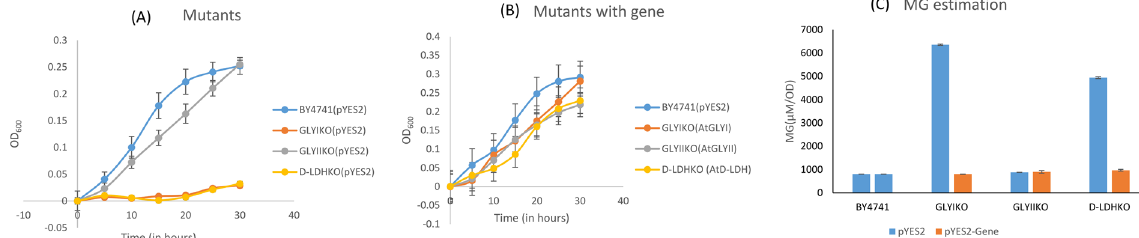
Figure 3. Stress tolerance assay in yeast mutants of MG detoxification enzymes in salinity stress: BY4741 wild type yeast cells, GLYIKO, GLYIIKO and D-LDHKO mutant yeast cells containing empty vector pYES2 were grown in presence of salinity stress ( A ). These mutant cells were transformed with their respective mutant genes cloned in pYES2 vector and the complemented yeast cells were grown in presence of salinity stress and their growth was monitored along with wild type BY4741 cells ( B ). MG levels were estimated in all of these samples after 30 hours and contribution of these genes in detoxification of MG was compared ( C ).